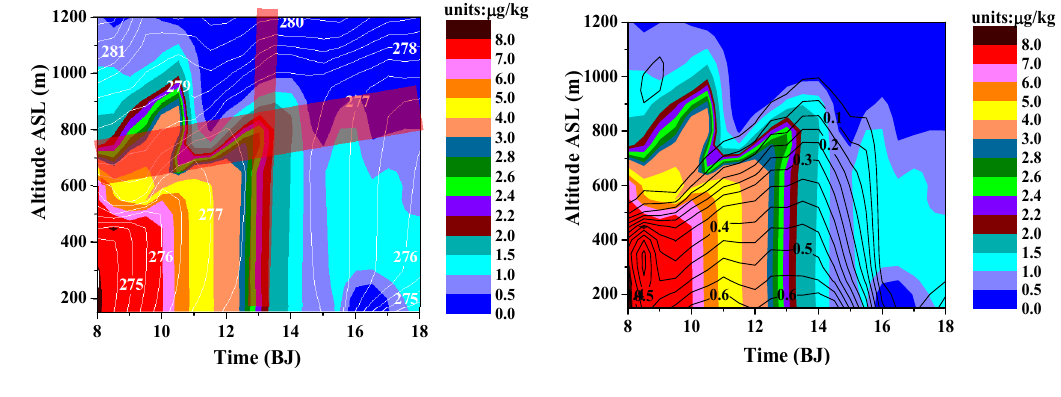
Figure 13. Simulated time-altitude diagram of the BC concentration (shading, unit: µ g / kg), potential temperature (white contour, unit: K), and TKE (black contour, unit: m − 1 s − 1 ) at grid point (97, 76). ( a ) BC concentration and potential temperature ; ( b ) BC concentration and TKE